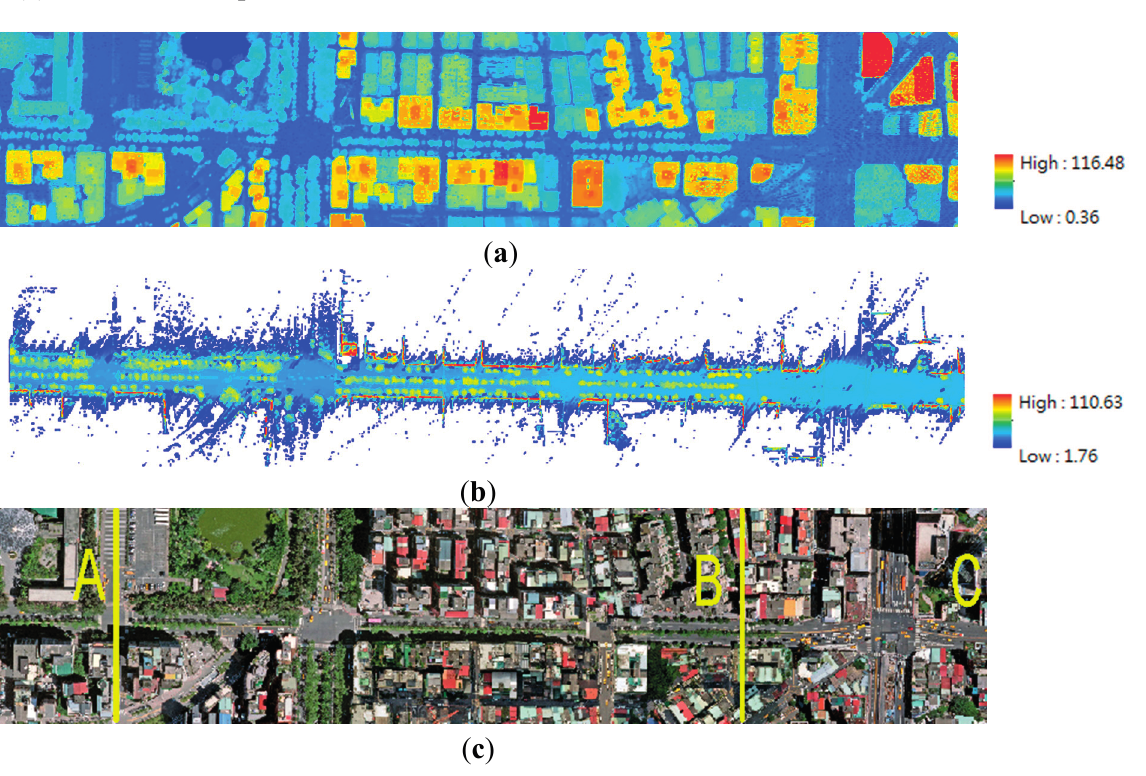
Figure 4. Test data: ( a ) ALS colored by elevation, ( b ) MLS colored by elevation, ( c ) reference orthophoto.